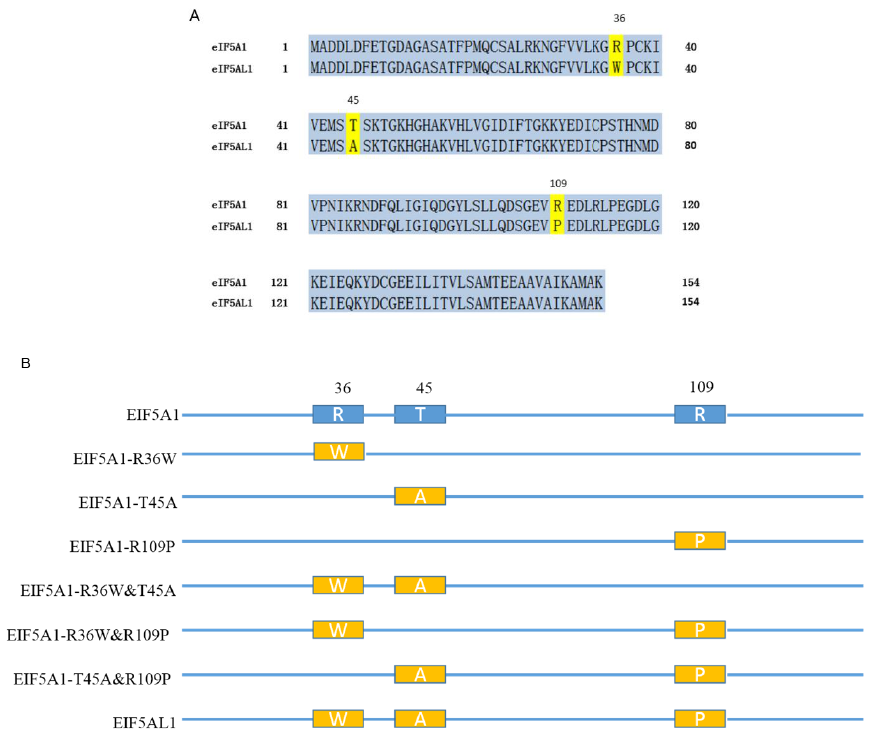
Figure 3. Comparison of the EIF5A1 and EIF5AL1 protein sequences. ( A ) Human EIF5A1 and EIF5AL1 protein sequences were downloaded from the UniProt database (https://www.uniprot.org/, accessed on 18 December 2019) with the ID numbers P63241 and Q6IS14, respectively. ( B ) Six EIF5A1 mutants were constructed based on the EIF5A1 and EIF5AL1 protein sequences. 2.3. Effects of the EIF5A1 Mutant Proteins on HeLa Cell Proliferation and Migration